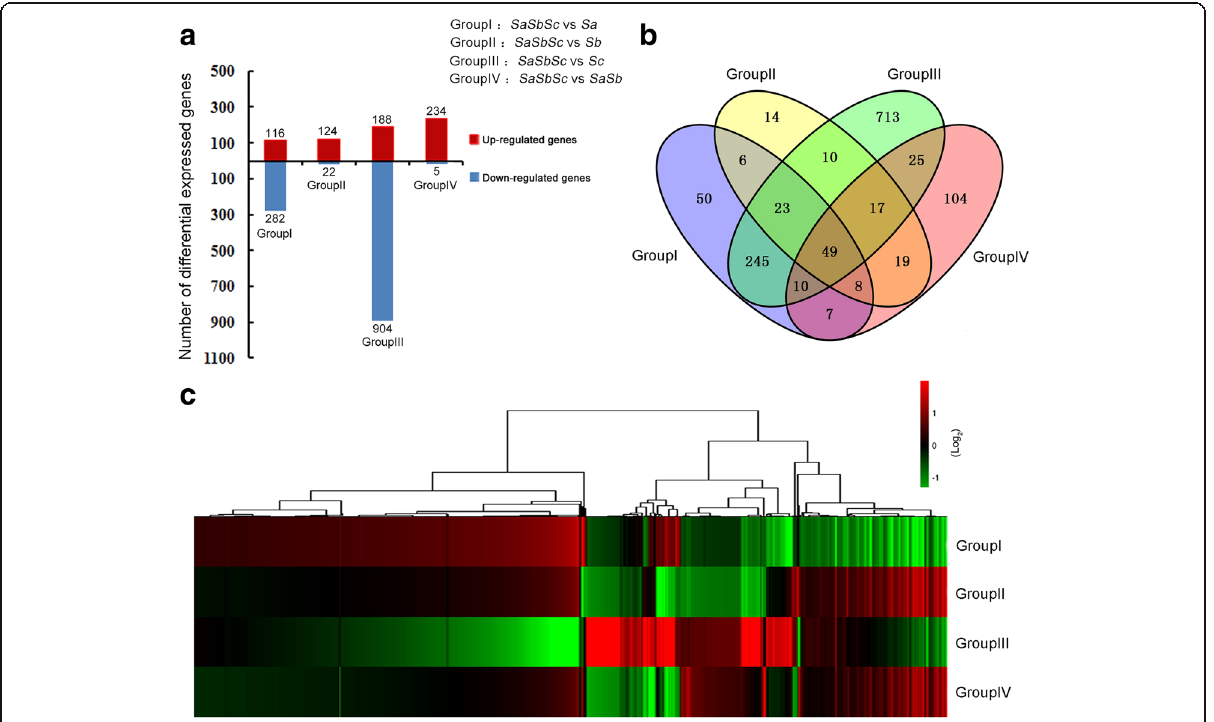
Fig. 4 Differentially expressed genes in four comparison groups. a Number of differentially expressed genes in four groups. Genes were divided into up- and down-regulated if their expression levels increased and decreased at least two-fold ( P <0.05), respectively. b Venn diagram of differentially expressed genes in four groups. c Expression patterns of different groups in autotetraploid rice hybrids. Red and green colors indicate up- and down-regulated genes,